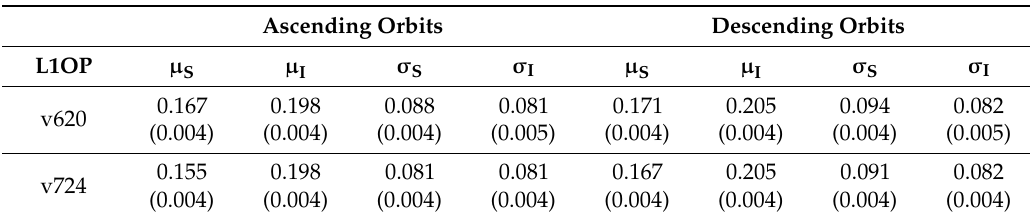
Table 4. SMOS and in-situ time series statistics and their CI95, 95% confidence intervals, given between parentheses. Ascending Orbits Descending